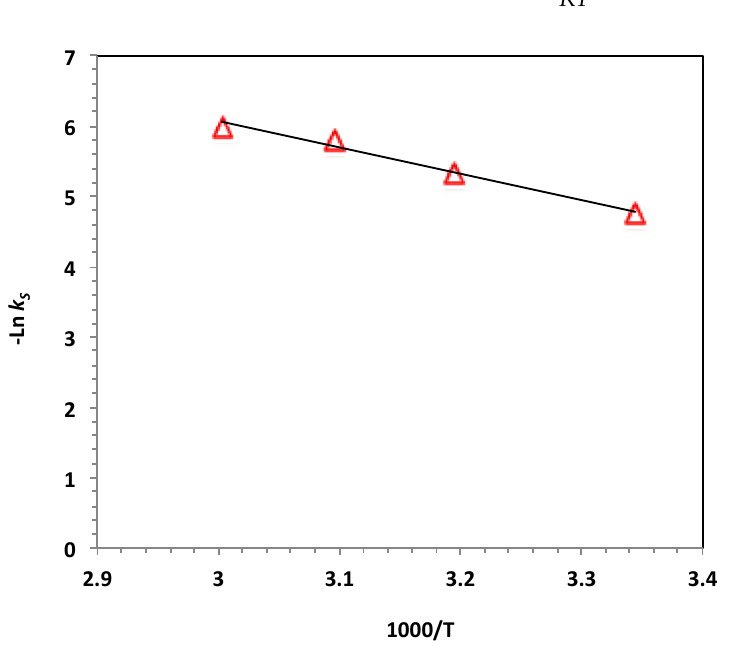
Figure 11. Plot of lnk2 versus 1000/T for the photo-Fenton-like reaction (solid lines represent least- squares fi tting).